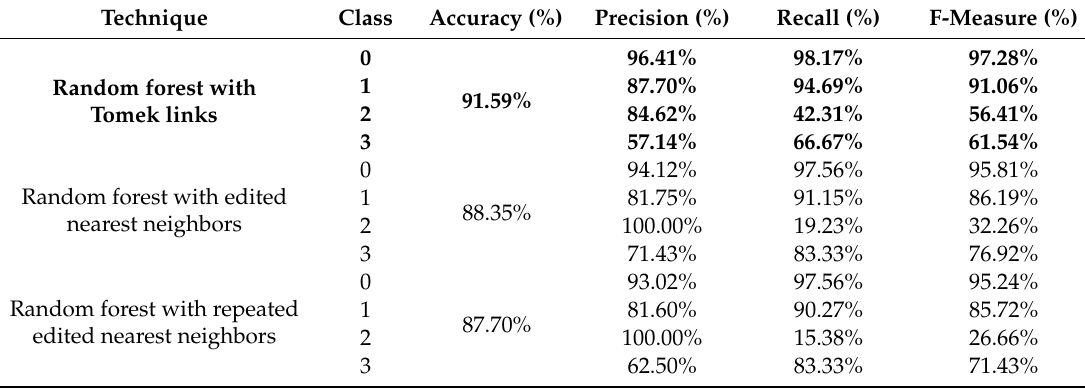
Table 7. Performance in terms of prediction with undersampling techniques used to handle imbalanced data.